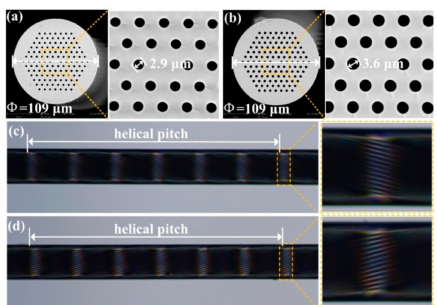
Figure 16. Cross-section of the ( a ) HLPFG and ( b ) inflated HLPFG (I-HLPFG) in the PCF; side-view microscope images of the ( c ) clockwise-twisted (CT)- and ( d ) anticlockwise-twisted (ACT)-IHLPFG